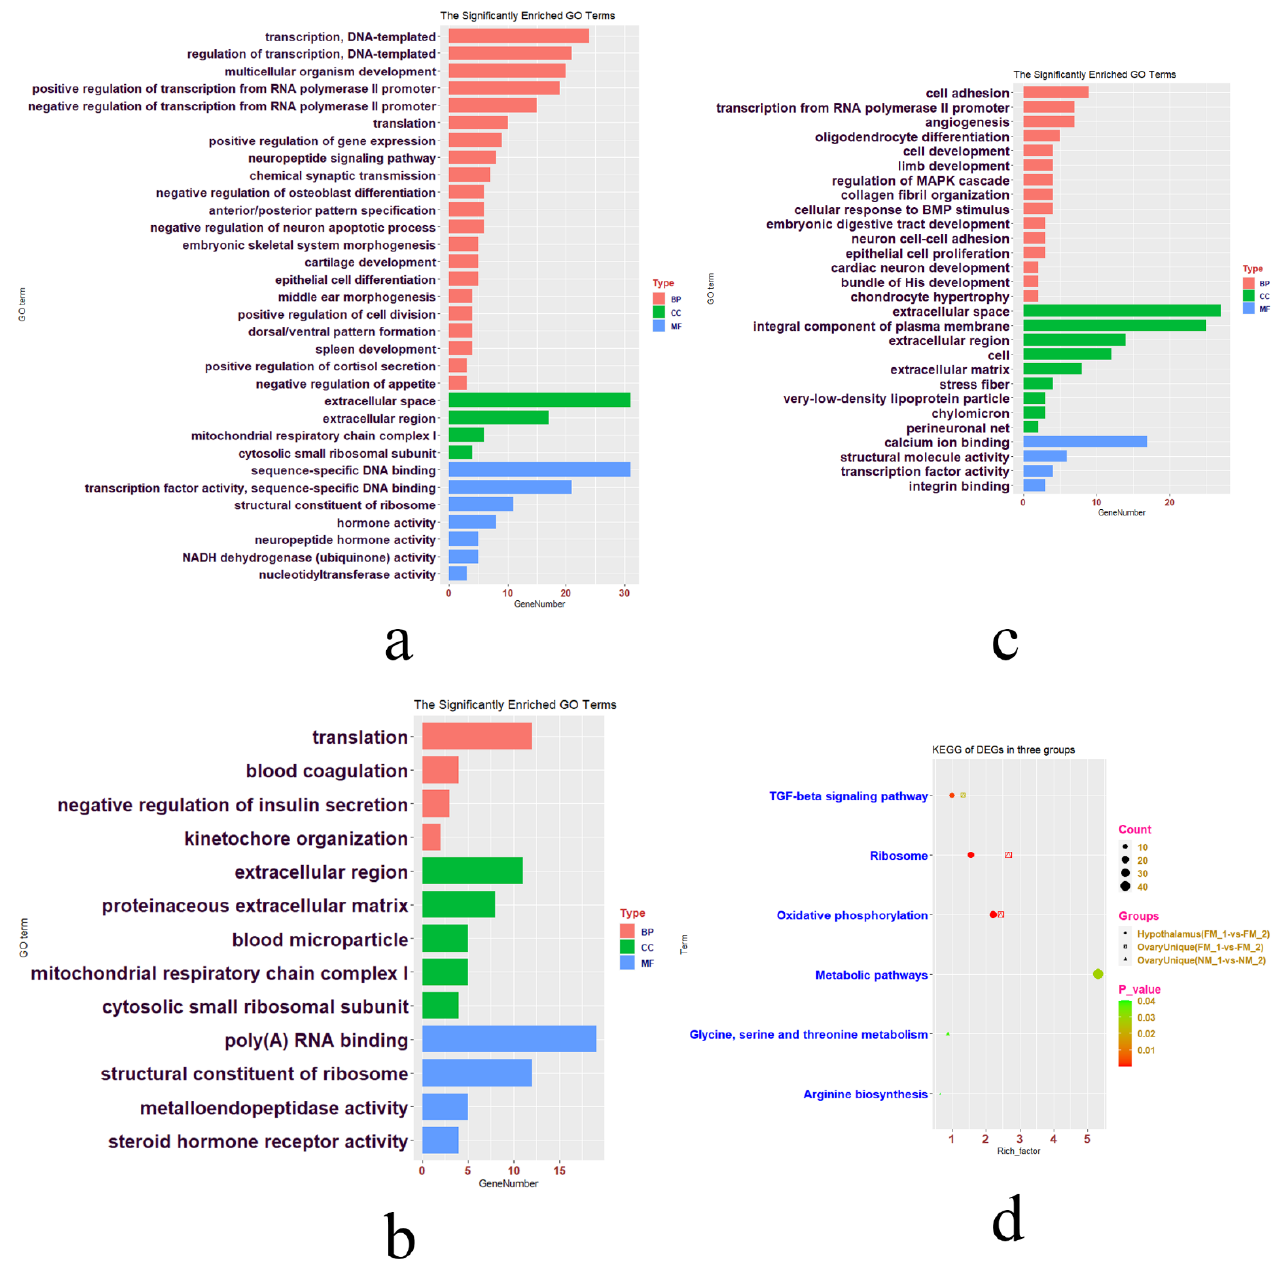
Figure 6. GO terms and KEGG pathways for three groups of DEGs in same periods for different molting patterns. The significant GO terms for the hypothalamus in the FM_1-vs-FM_2 group ( a ). The significant GO terms for unique 537 ovarian DEGs in the FM_1-vs-FM_2 group ( b ) and unique 524 ovarian DEGs in the NM_1-vs-NM_2 group ( c ). The significant KEGG pathways of the above three group of DEGs.